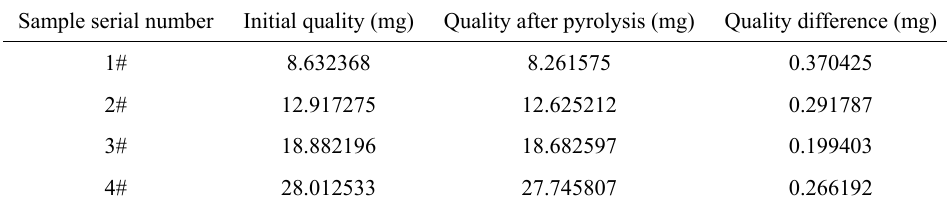
Thermogravimetric analysis